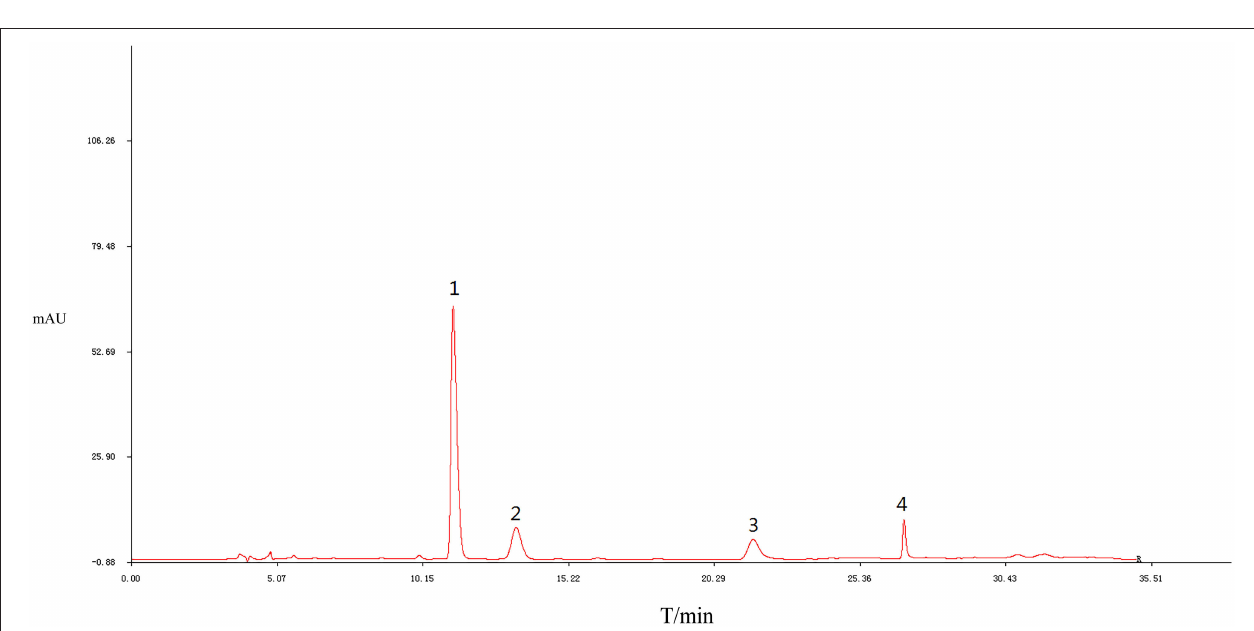
for protein–protein interaction (PPI) network analysis. Species for Homo sapiens and isolated nodes were excluded and evaluated according to the degree values of the nodes (39).